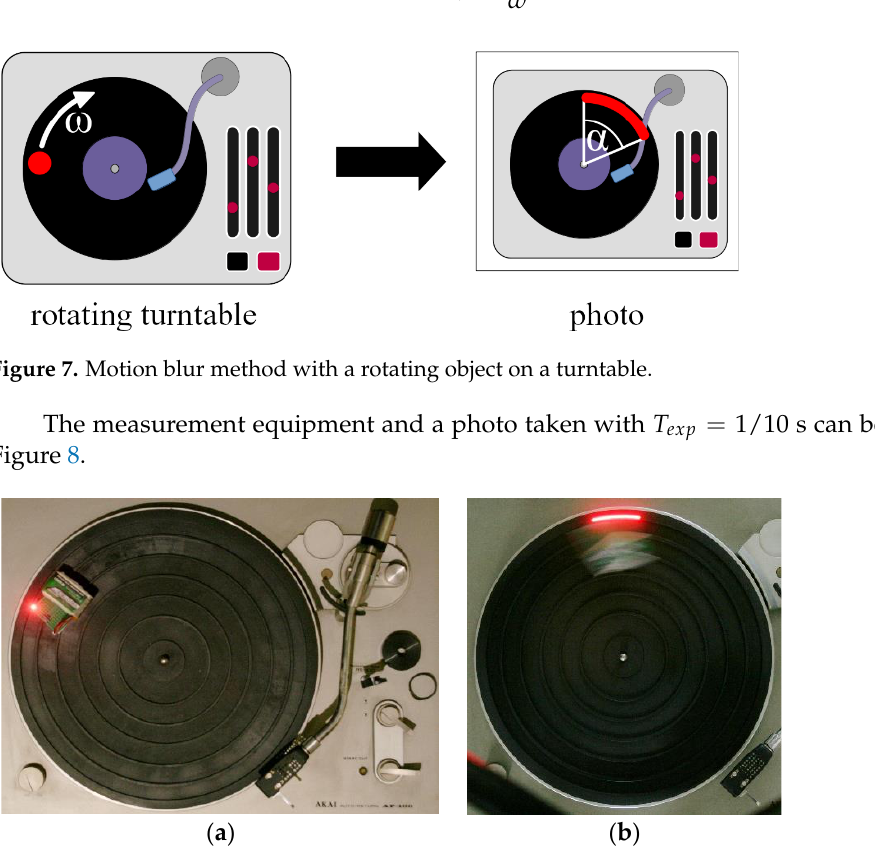
Figure 8. ( a ) The turntable with an LED light source. ( b ) Measurement with 𝑇 𝑒𝑥𝑝 = 1/ 10 s.